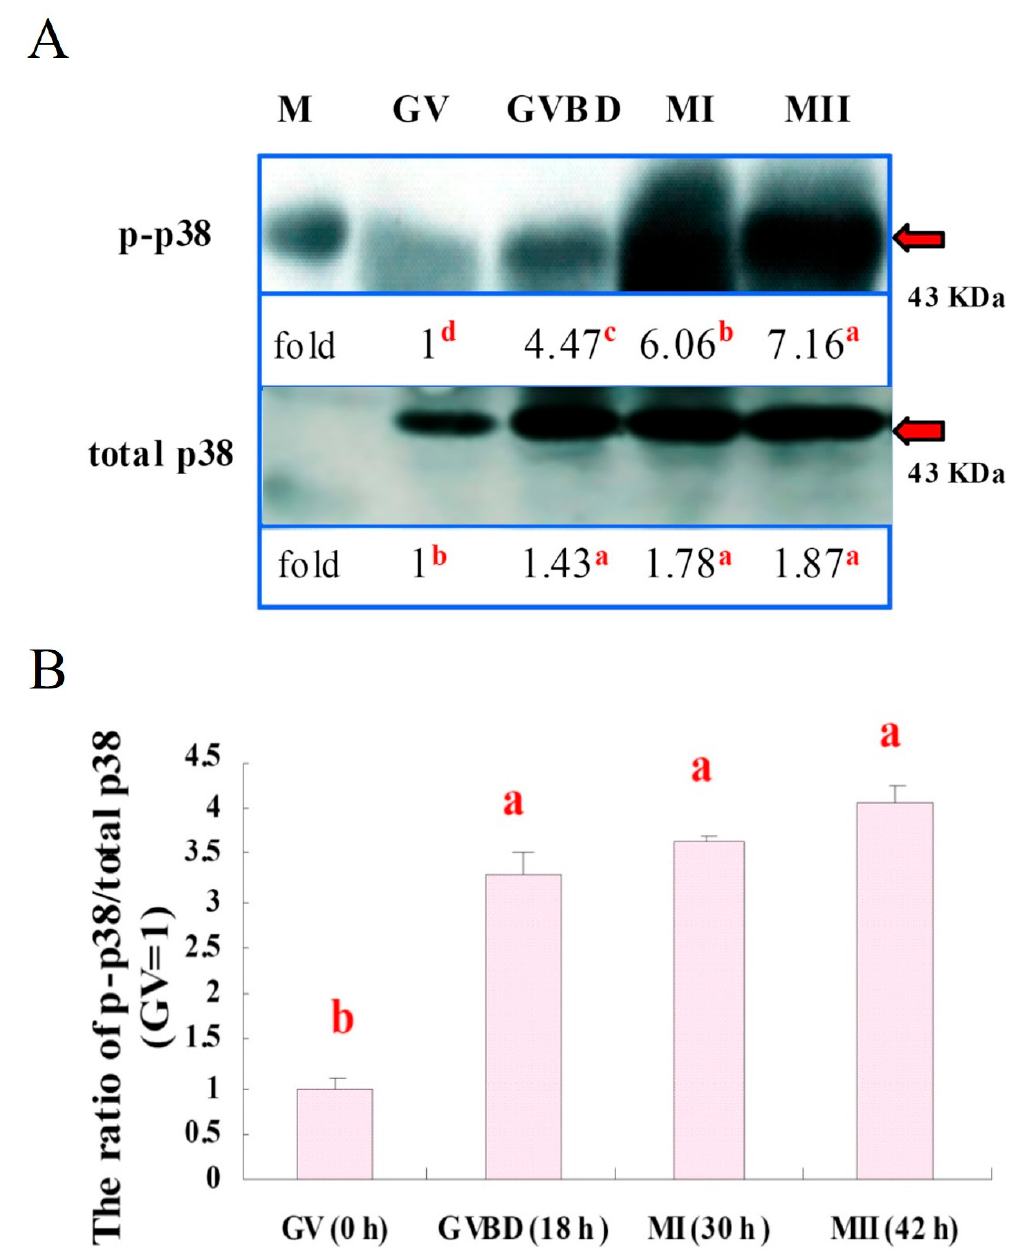
Figure 5. Expressions of p38 and phosphorylated p38 (p-p38) in porcine oocytes during IVM. ( A ) A representative immunoblot of total p38 and p-p38; the expression of p-p38 increased progressively during the IVM ( p < 0.05). The expressions of both total p38 and p-p38 were the lowest ( p < 0.05) in the GV stage. ( B ) Relative activity of p38, however, increased at the GVBD ( p < 0.05) and remained high at the MI and MII stages. Each lane of the SDS-PAGE gel contained 150 oocytes (three replicates). a–d, lanes or bars without a common superscript differed ( p < 0.05). Bars are means ± SEM. M: marker.